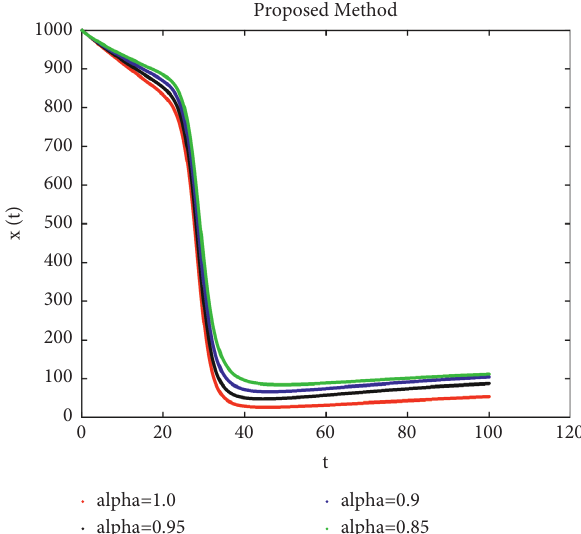
Figure 2: Dynamical behavior of concentration of uninfected (susceptible) cells at τ � 1 and various fractional order under power law kernel.